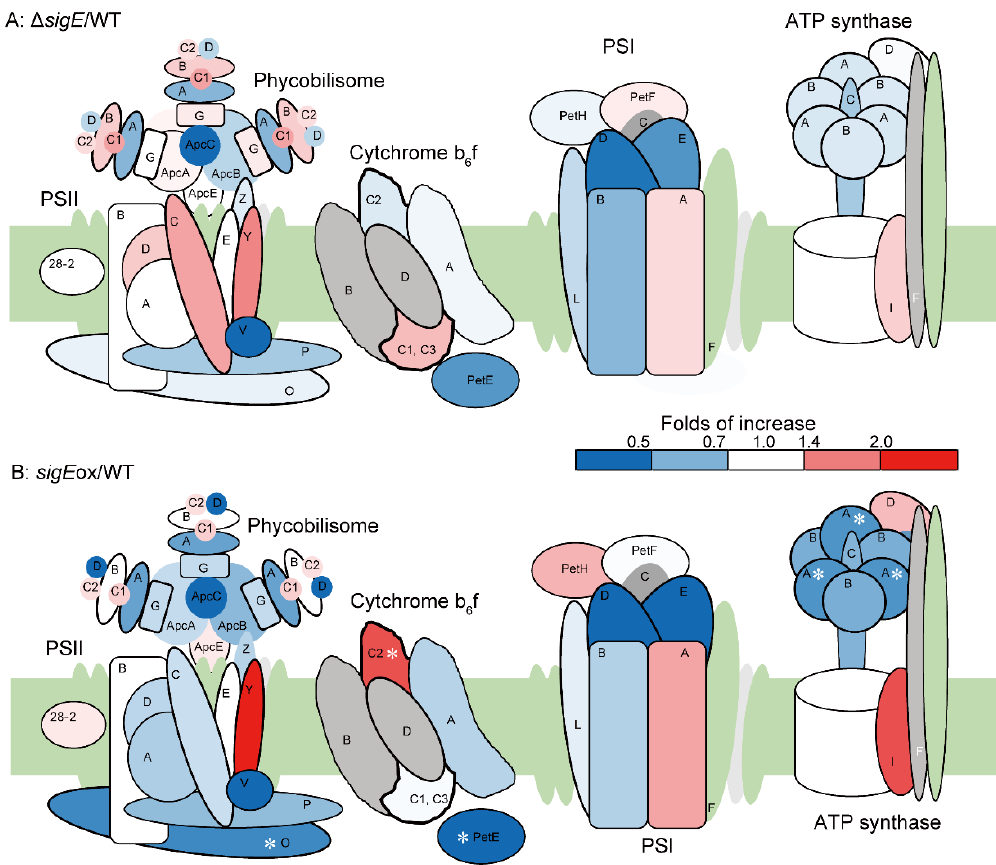
Figure 3. Effect of sigE deletion and overexpression on the expression of photosystem-related proteins in Synechocystis sp. PCC 6803. Relative expression levels [Δ sigE /WT ( A ) and sigE ox/WT ( B )] of proteins determined by the targeted proteome analysis were represented by heat maps. Asterisks indicate a significant difference in terms of both two-sided Student’s t -test ( α 0.05) and the fold increase (>1.5 and <0.67).